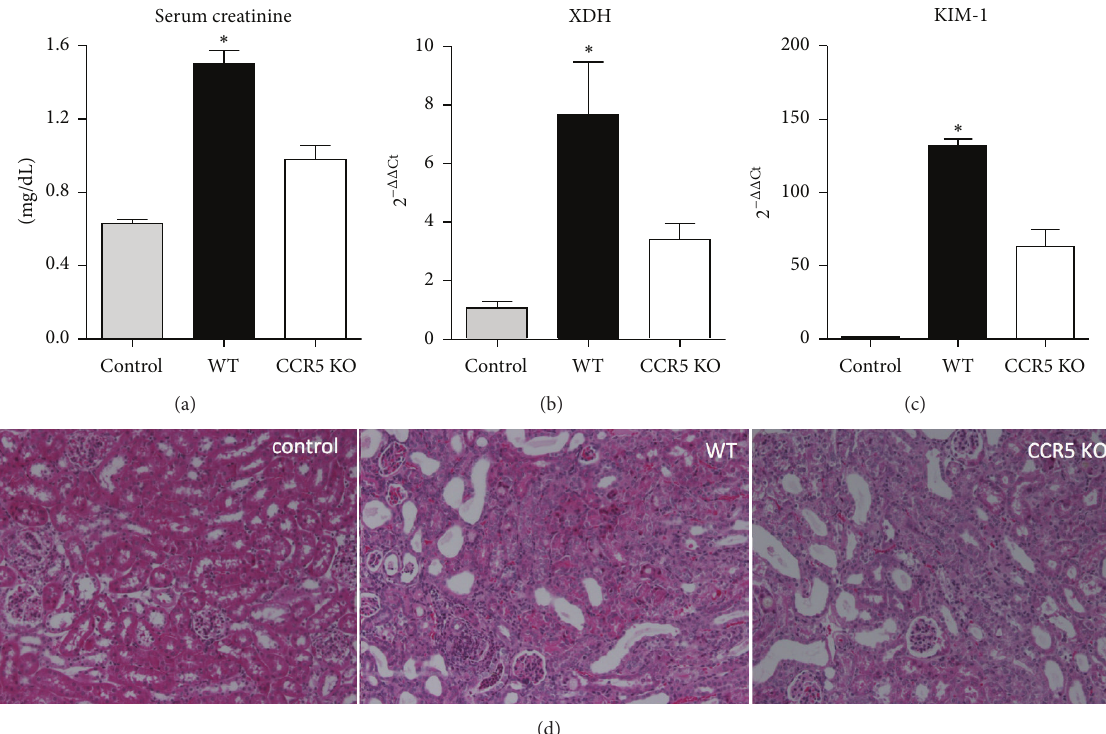
Figure 4: Lack of CCR5 promotes less renal dysfunction in TIN. (a) Serum creatinine levels were dosed in control (that received standard food), WT, and CCR5 animals (that received adenine-enriched food). In panels (b) and (c) we can observe the transcripts levels of XDH and KIM-1, respectively. (d) H&E staining of kidney sections of the groups described before. ∗ 𝑃 < 0.05 versus other